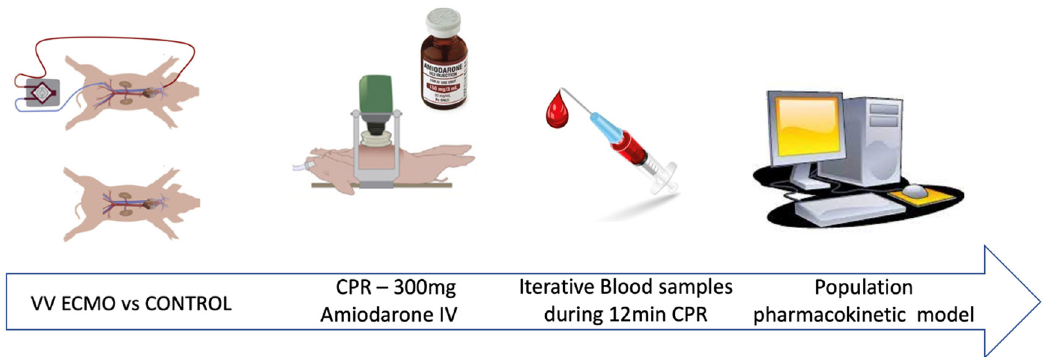
Figure 1. In vivo experimental protocol. ARDS: acute respiratory distress syndrome; VV ECMO: veno venous extracorporeal membrane oxygenation; CPR: cardiopulmonary resuscitation. IV: intravenous bolus.